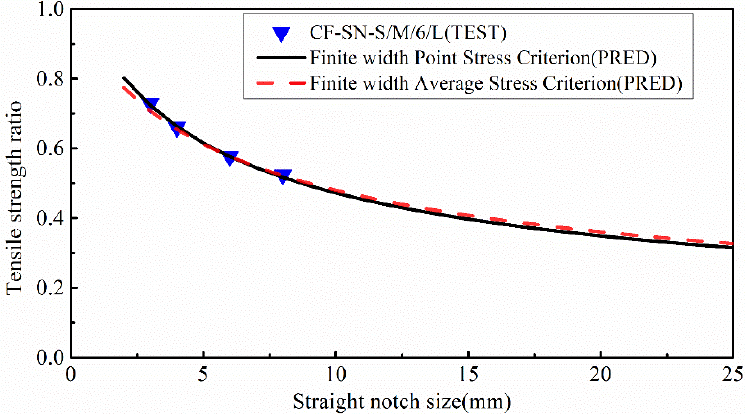
Figure 25. Comparison of the tensile strength ratio curves of the equal 𝑊 /2 𝐶 ratio group predicted by the point stress criterion and average stress criterion in the finite ‐ width stress criterion with test results; it meets the curve of the test results well.